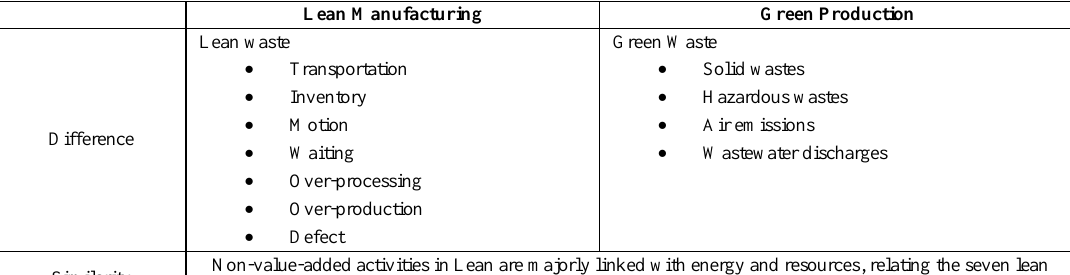
Non-value-added activities in Lean are majorly linked with energy and resources, relating the seven lean Similarity wastes to the wastes described in the sense of green